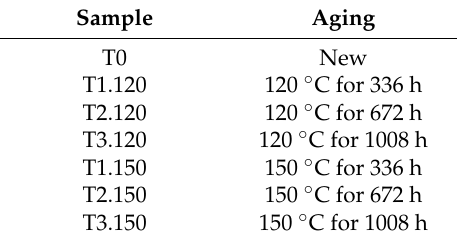
Table 1. Samples and treatment.